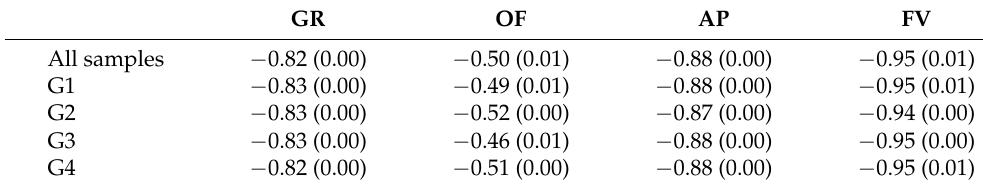
Table 2. Estimated conditional uncompensated own-price